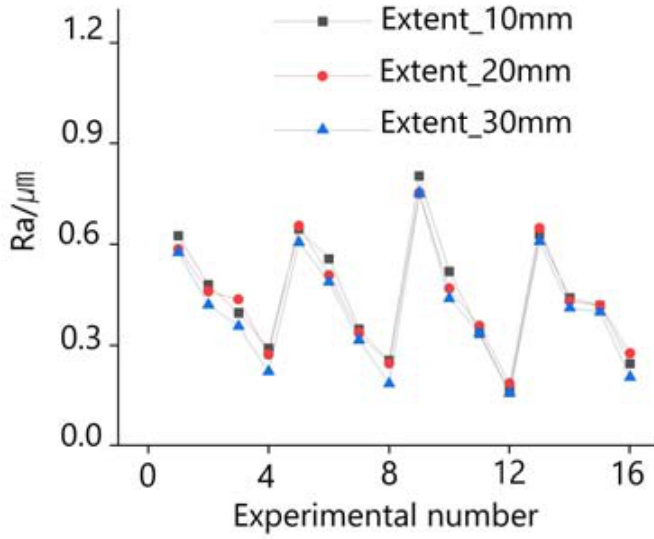
Figure 6. Comparison chart of multi-group experimental results.